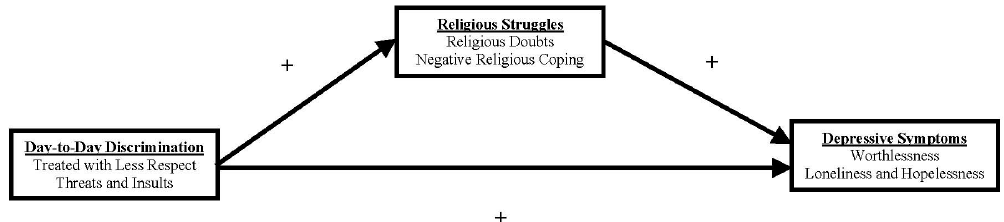
Figure 1. Conceptual Model Linking Day-to-Day Discrimination and Depressive Symptoms with Religious Struggles.